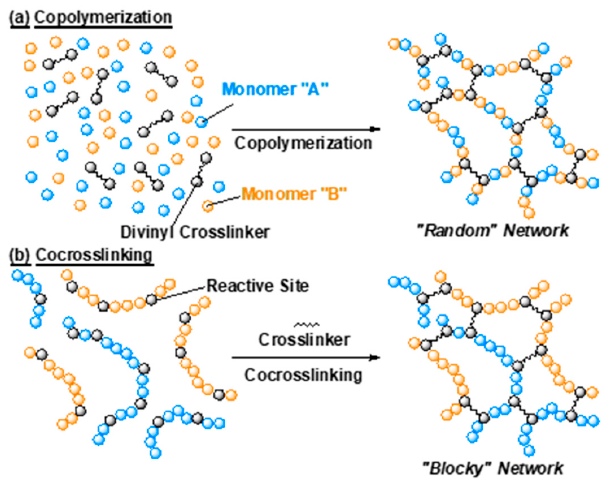
Figure 1. Schematic illustrations of gel network structure consisting of two kinds of monomer prepared by ( a ) copolymerization and ( b ) co-crosslinking.